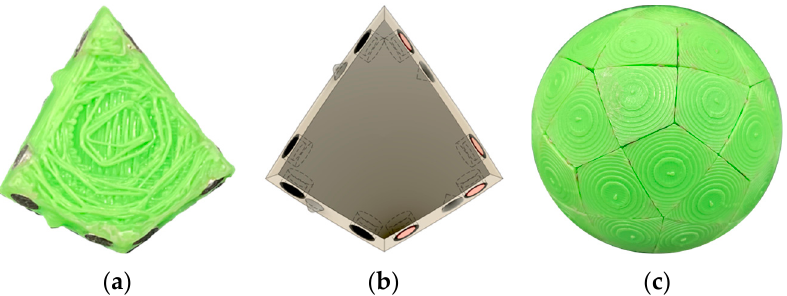
Figure 13. A T1 icosahedral model with sixty identical rhombic subunits. ( a ) An individual 3D printed subunit with its magnets glued into its edges; ( b ) A render of an individual subunit with its magnet map, and hole and peg arrangement, for 3D printing, created in Fusion 360; ( c ) A self-assembled spherical model with 60 subunits.